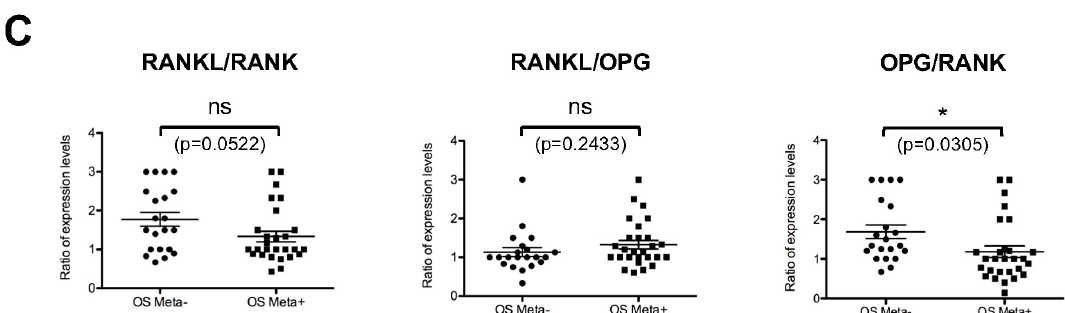
Figure 5. Tissue array analysis of RANK, RANKL and OPG expressions in a cohort of 50 biopsies of patients with ( n = 28) and without ( n = 22) metastases at time of diagnosis. Representative views of the different immuno-stainings are presented ( A ) with enlargement inset to clearly show the stained osteosarcoma cells. Statistical analyses (Student test) of the staining based on the percentage of stained osteosarcoma cells revealed a significantly lower number of positive cells for RANKL and OPG in the metastatic patient group, while no difference was observed between the two groups concerning the number of RANK-expressing cells ( B ). Statistical analysis of the three ratios between these factors, established individually for each patient, showed that only the OPG/RANK ratio was significantly different between the two groups with lower values in the metastatic patient group ( C ). ns: not significant. *: p < 0.05. p values are given for each